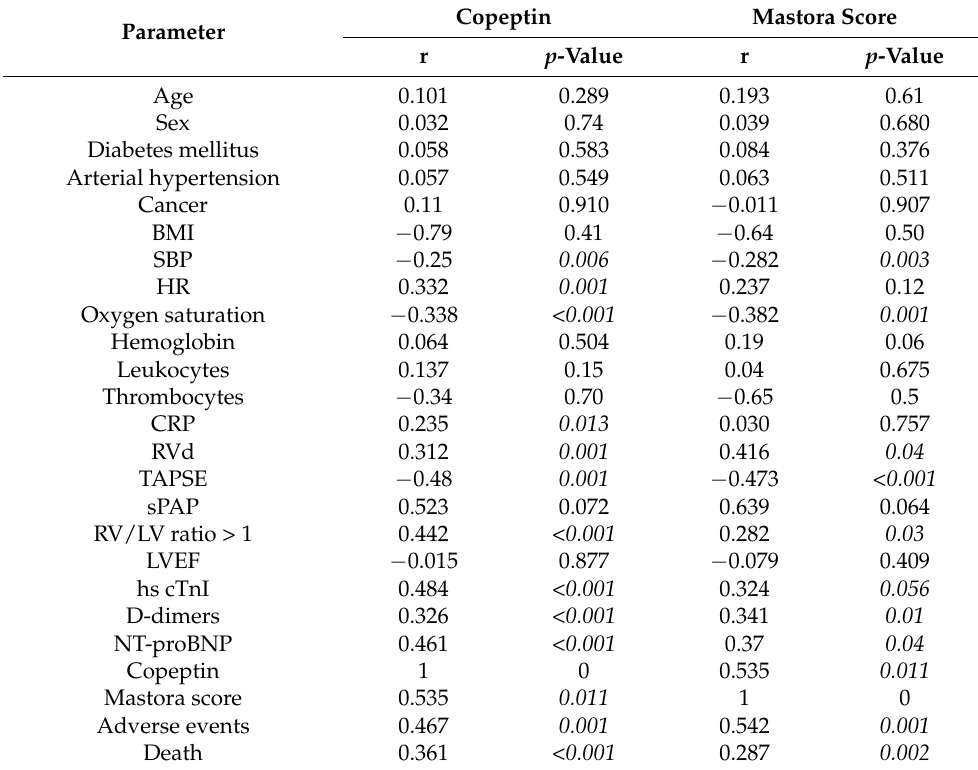
Table 4. Correlation between copeptin and Mastora score and clinical, biologic and imagistic parameters.